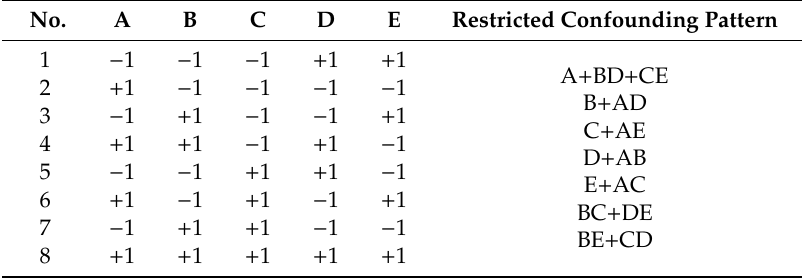
Table 3. Array of